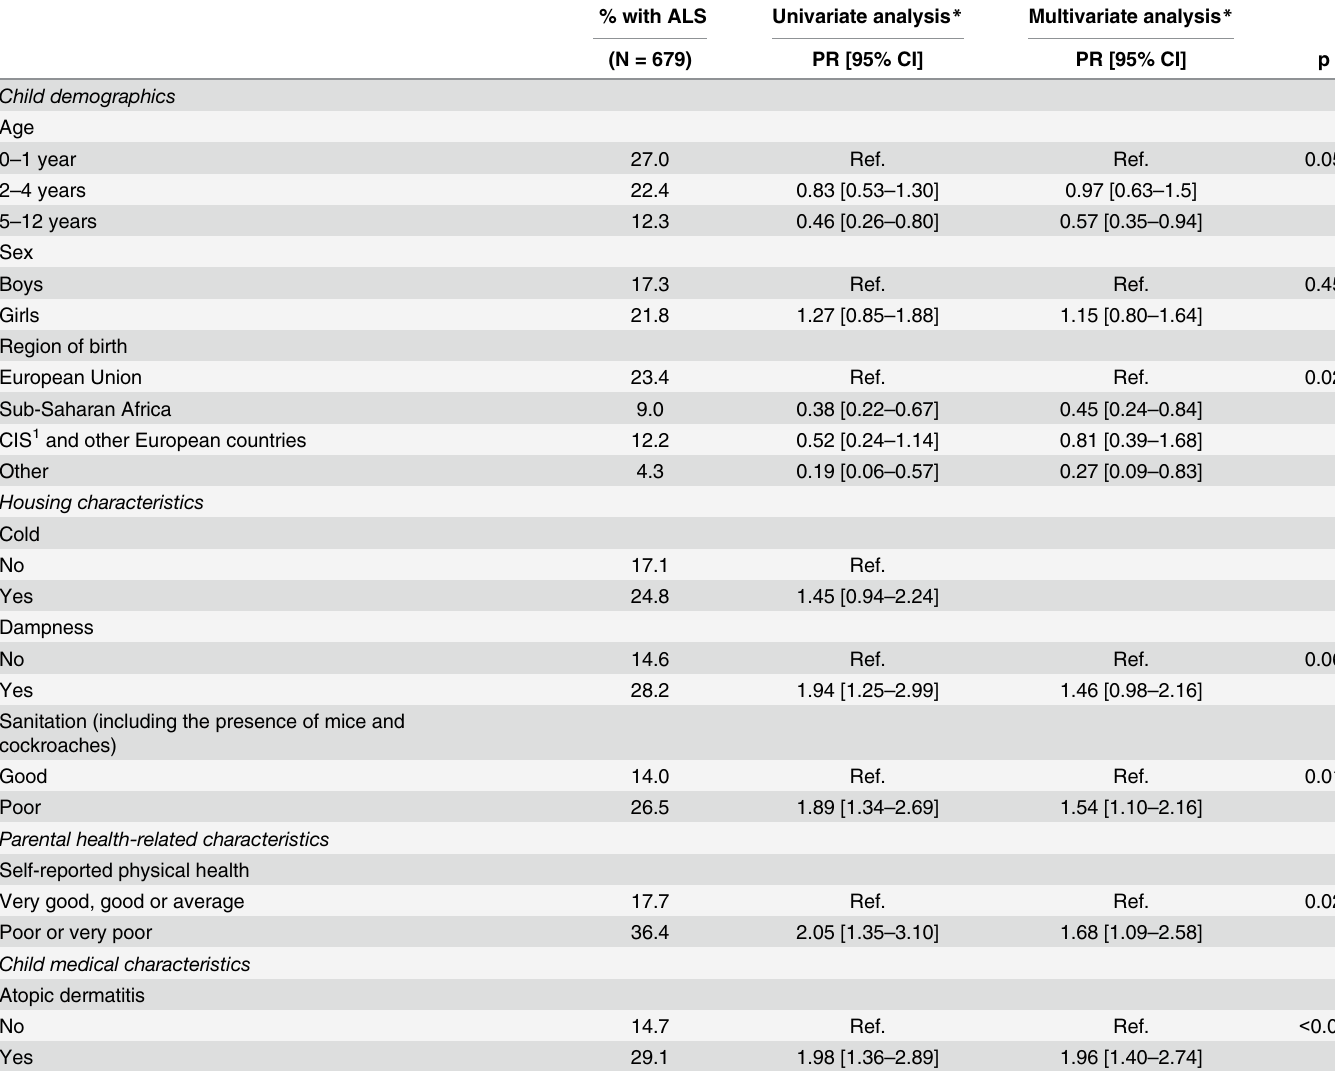
Table 3. Factors associated with asthma-like symptoms — univariate and multivariate